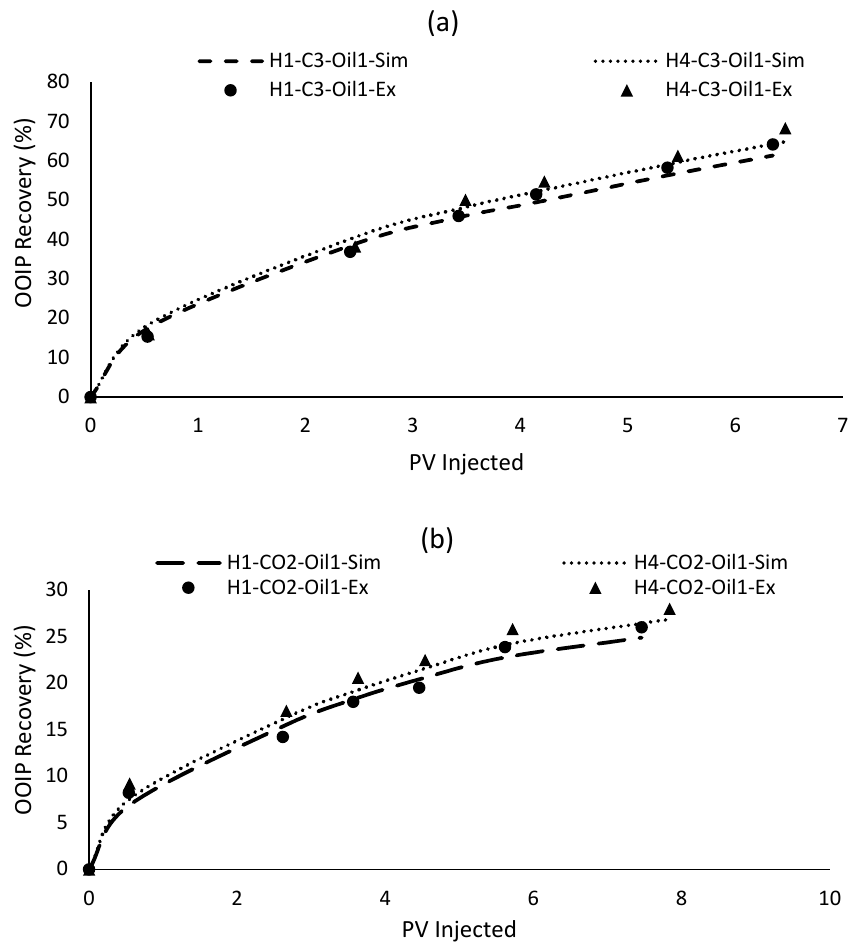
Figure 11. The effect of fracture length on the recovery factors in conventional VAPEX and patterns H1 and H4 using propane ( a ) and carbon dioxide ( b ).